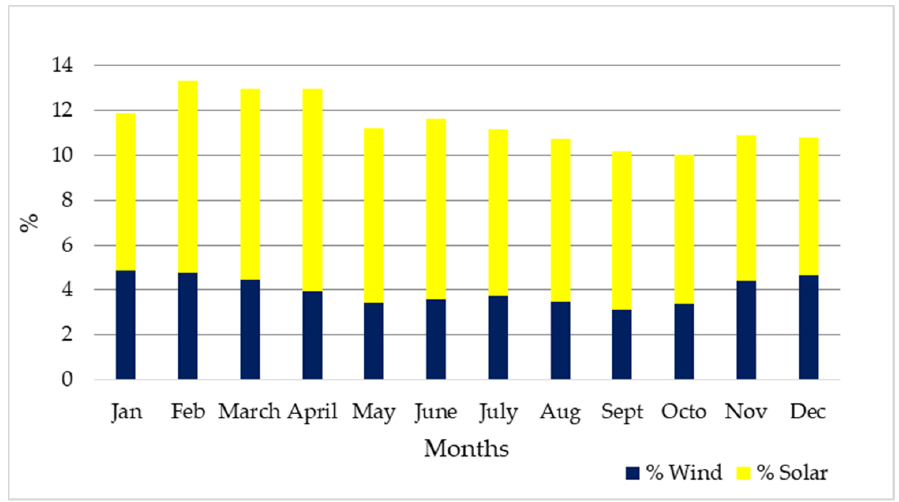
Figure 12. Renewable energy penetration rate (%) in 2019. Source: own elaboration with the model [27–29].